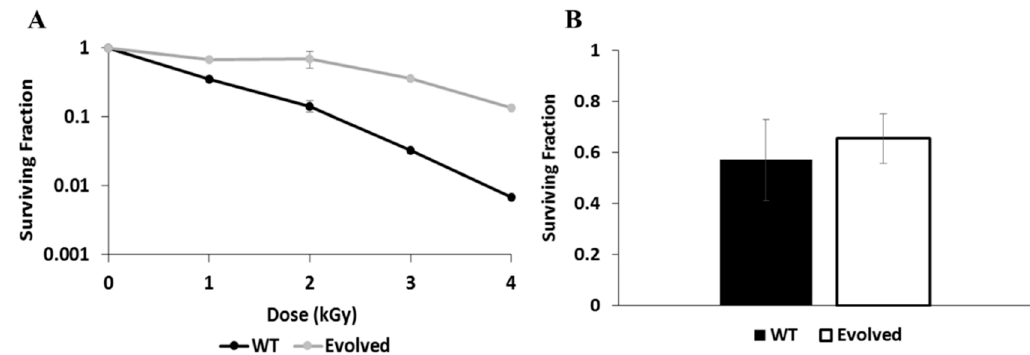
Figure 1. Resistance of wild type (WT) and Evolved strains to γ -radiation. ( A ) Survival curve showing the percent of cells recovered for each strain after exposure to increasing doses, up to 4 kGy. ( B ) Survival of each strain after exposure to a dose of 500 Gy and recovery in fresh medium for 1 h, measured from a subset taken from the same samples that were processed for proteomics.